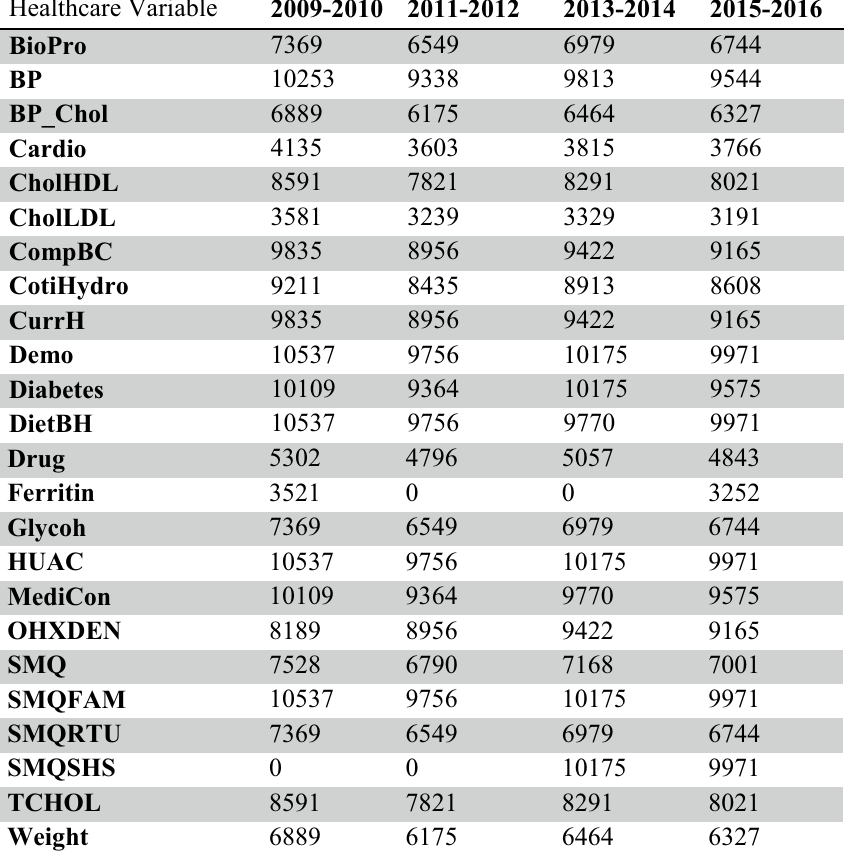
Table 1 Summary of data for preventive parameters in NHANES Healthcare